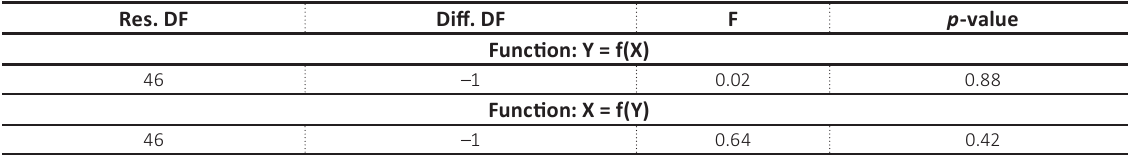
Table E5. SDGI rank 2016 (X) and government corporate ESG disclosure (Y) Res. DF